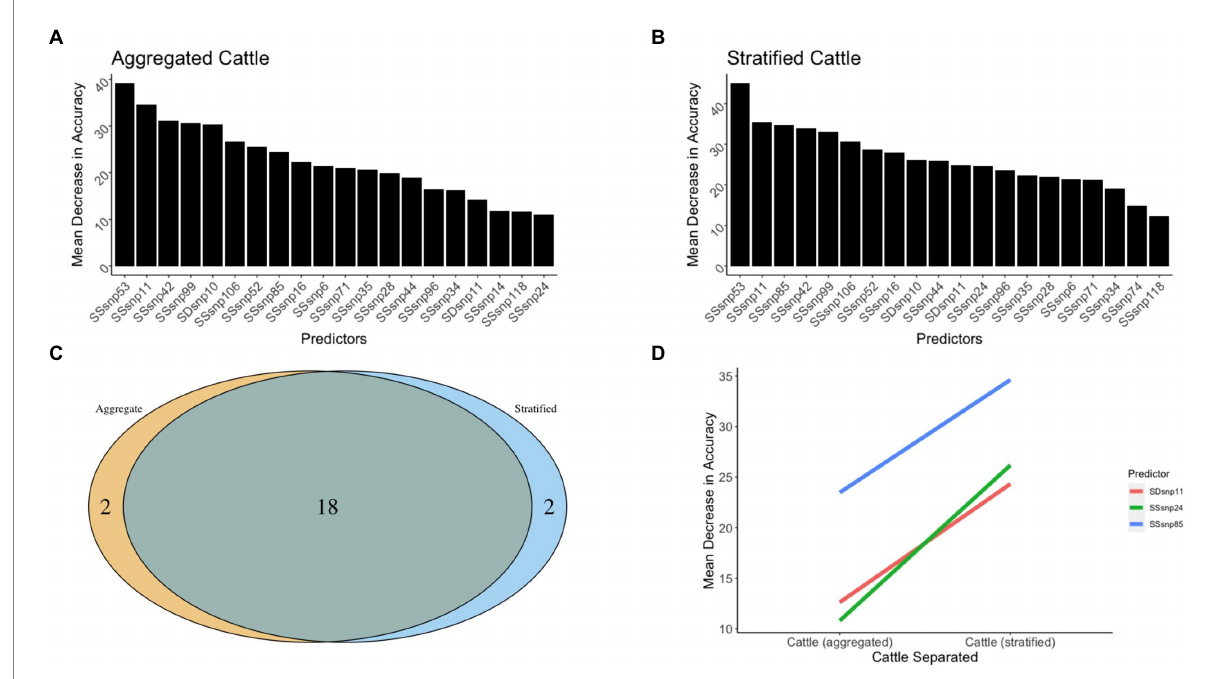
FIGURE 7 The 20 top predictors for cattle related random forest models. The 20 top predictors were shown for the (A) aggregated cattle and (B) stratified cattle random forest models. (C) A Venn diagram to identify regions that were shared and unique across models. (D) Three genomic regions between the cattle vs. wildlife models that increase or decrease model accuracy as the scales move from aggregated to